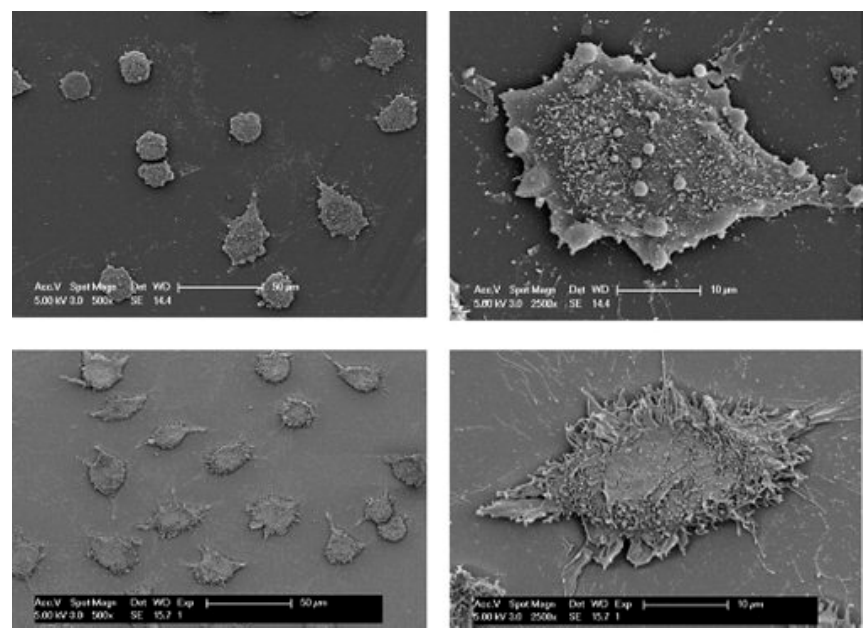
Figure 8. Scanning electron microscopy images (500×, 2500×) showing the viability and adherence of L929 fibroblast cells at 24 h after cultured on the surfaces of conventional PI2611 cured at 200 °C (top) and at 400 °C (bottom). Reproduced from [27], with permission from © 2008 John Wiley and Sons.